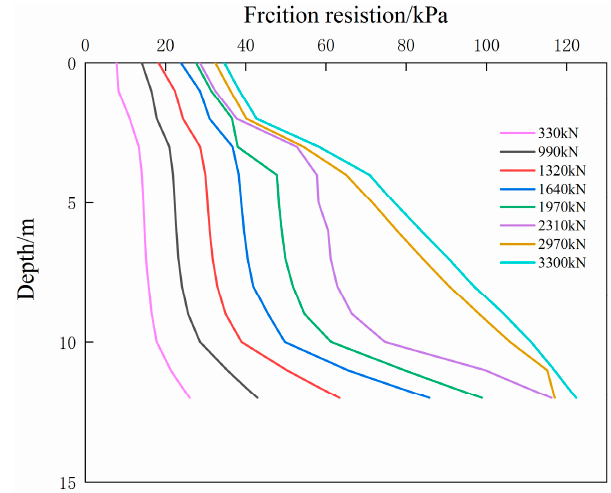
Figure 11. Friction resistance between the cemented soil and soil.